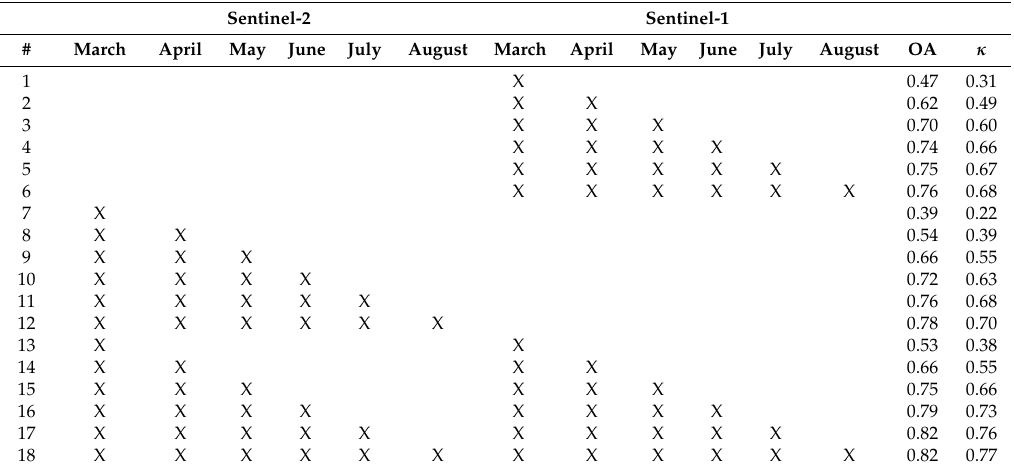
Table 2. Overall Accuracy (OA) and kappa coefficient ( κ ) of the different classification